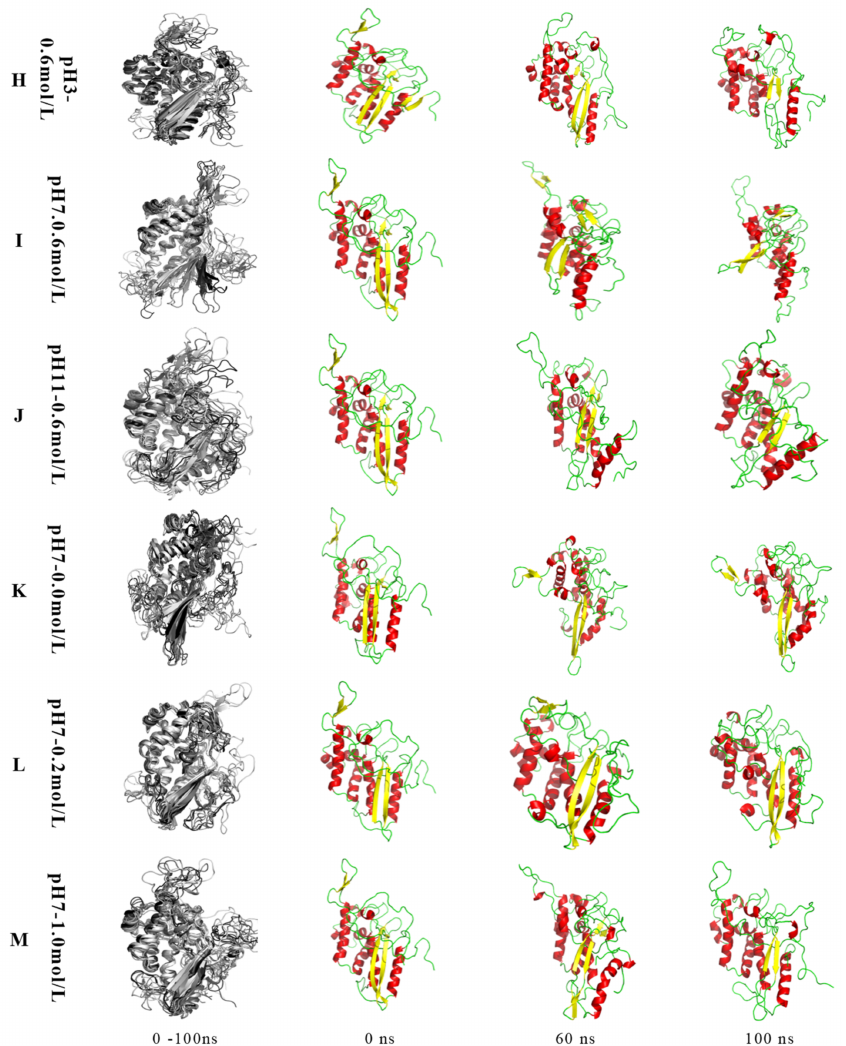
Figure 3. Secondary structure assignments by residue over simulation time for each system ( A – G ) and trajectory frames superposition at 0, 100, and 200 ns highlighting native secondary structures for each system ( H – M